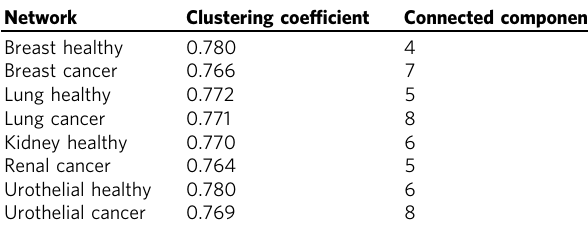
Table 1 Topological properties of the complete